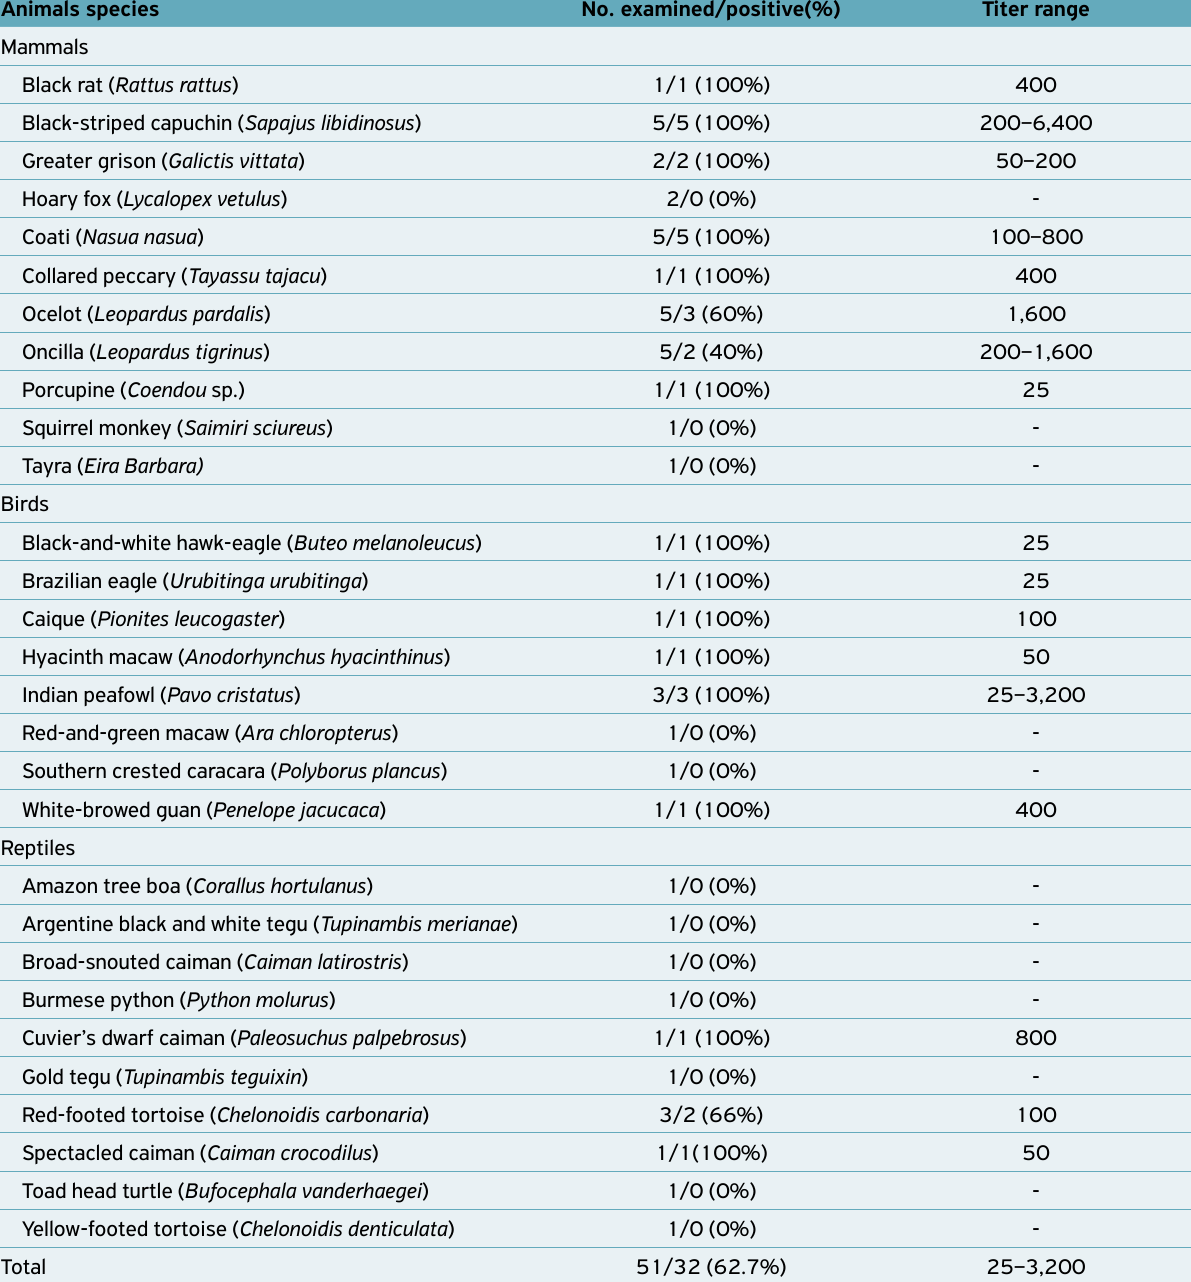
Table 1. Presence of anti- Toxoplasma gondii antibodies (MAT ≥ 25) in wild captive animals at the Arruda Câmara Zoological- Botanical Park in João Pessoa, northeastern Brazil. Animals